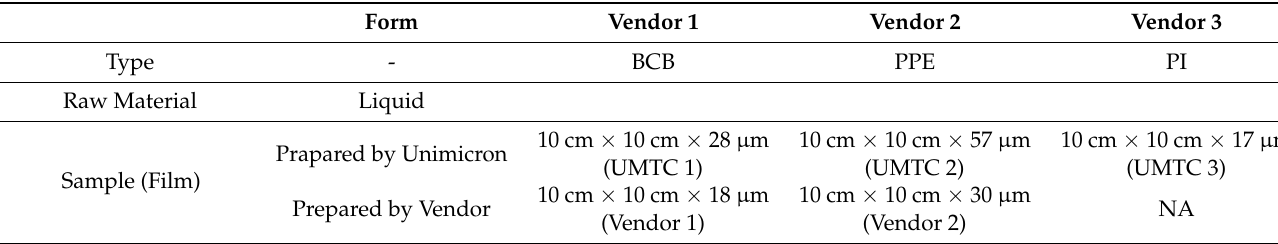
Figure 4. Speed vs. time. Table 2. Sample